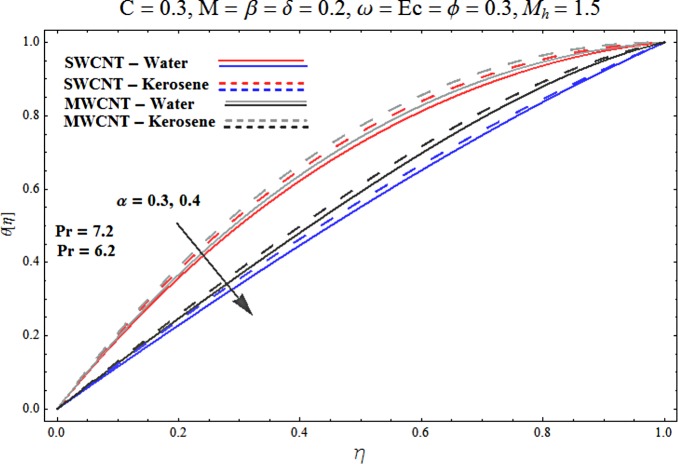
Effect of α on θ.